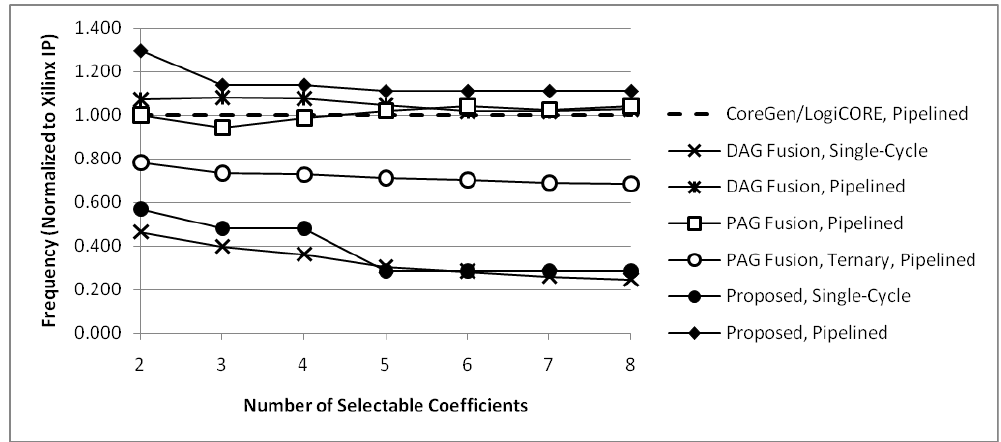
Figure 17. Maximum operating frequency for DAG fusion [11,13], PAG fusion [13] and proposed (16 × 16)-bit KCMs with two to eight selectable coefficients. DAG fusion and PAG fusion units are normalized to CoreGen as presented in Möller et al. [13], proposed units are normalized to a LogiCORE IP multiplier-based unit.